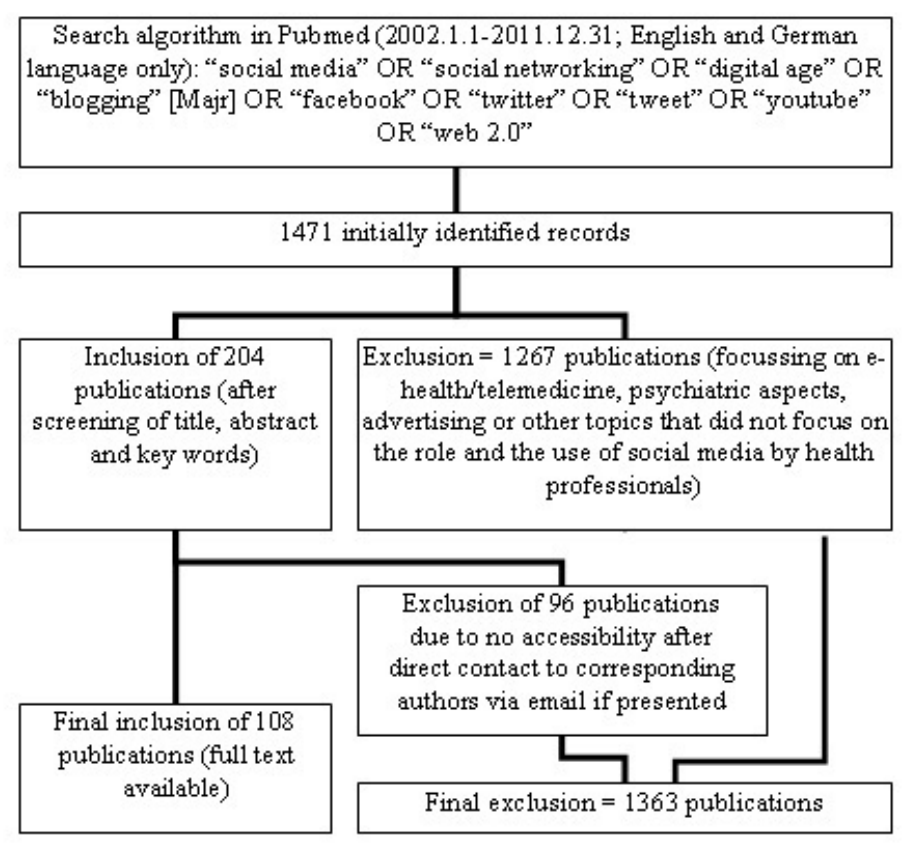
Figure 1. Flowchart illustrating identified